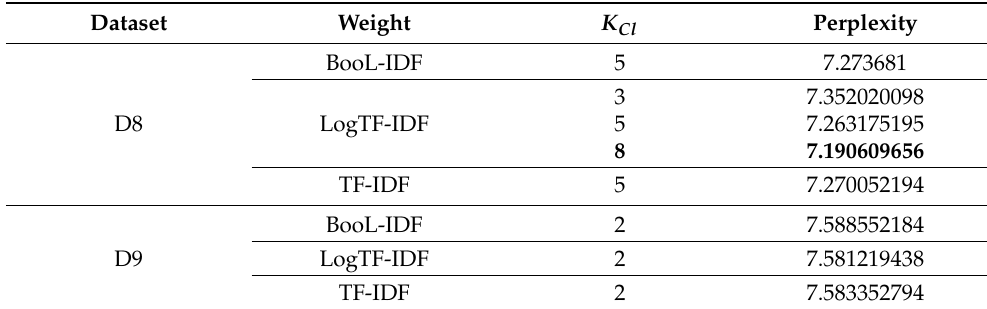
Table 14. Experimental results for dataset D8 and D9 for the probabilistic approach.